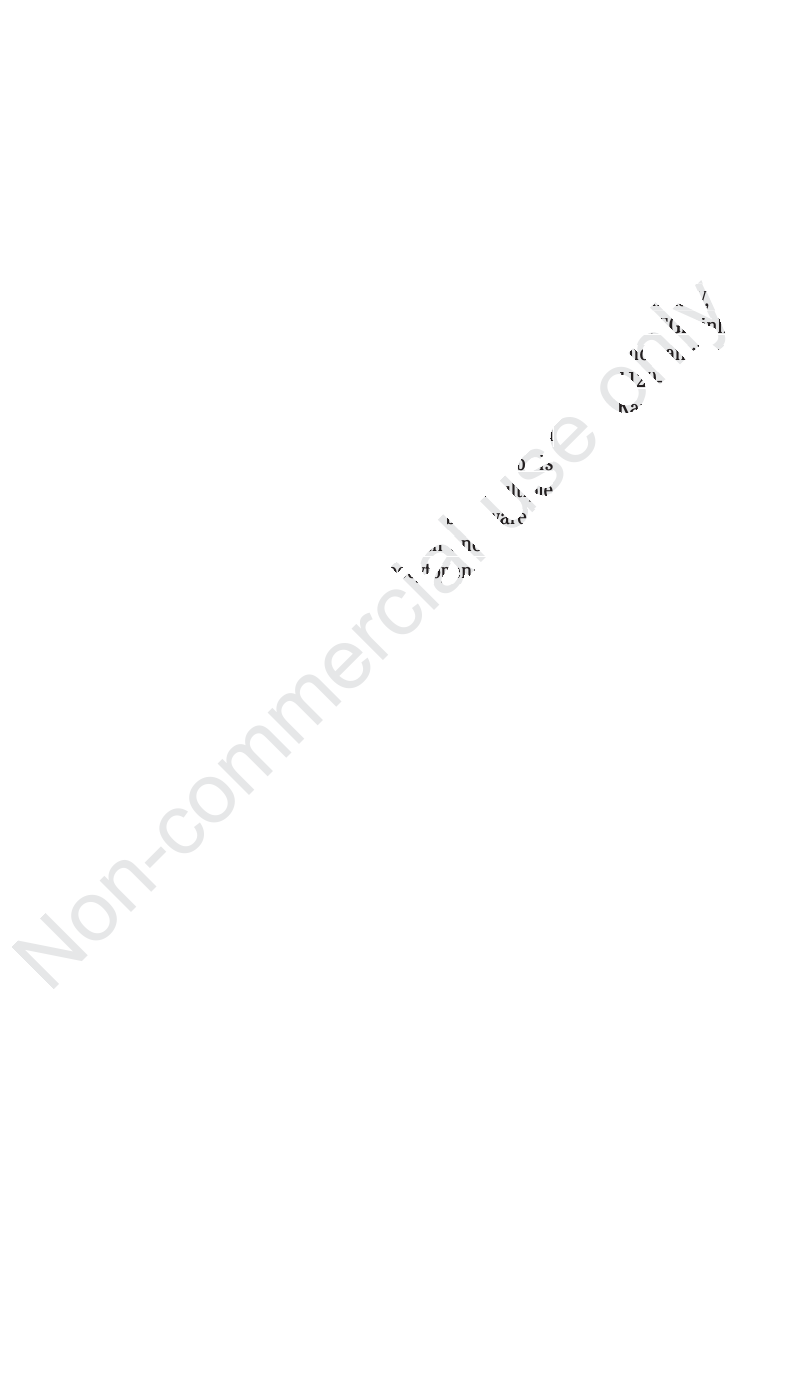
Table 1. Laboratory values during velcade